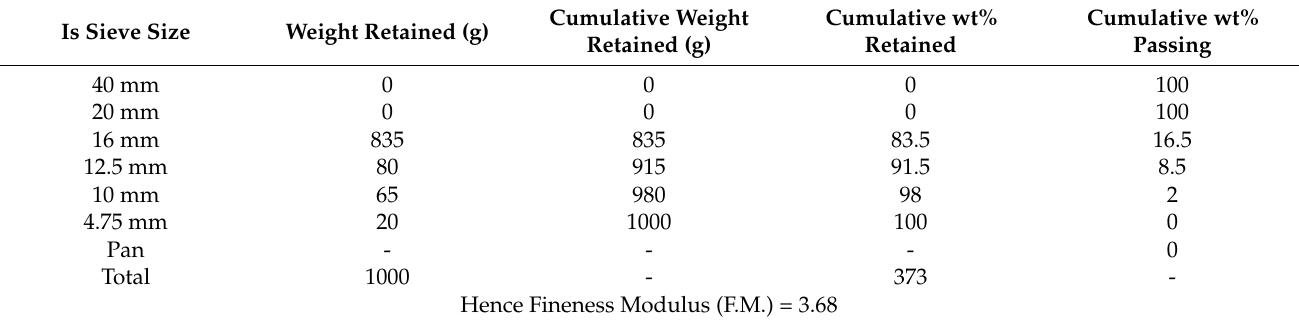
Table 2. Sieve analysis of coarse aggregate (16 mm).